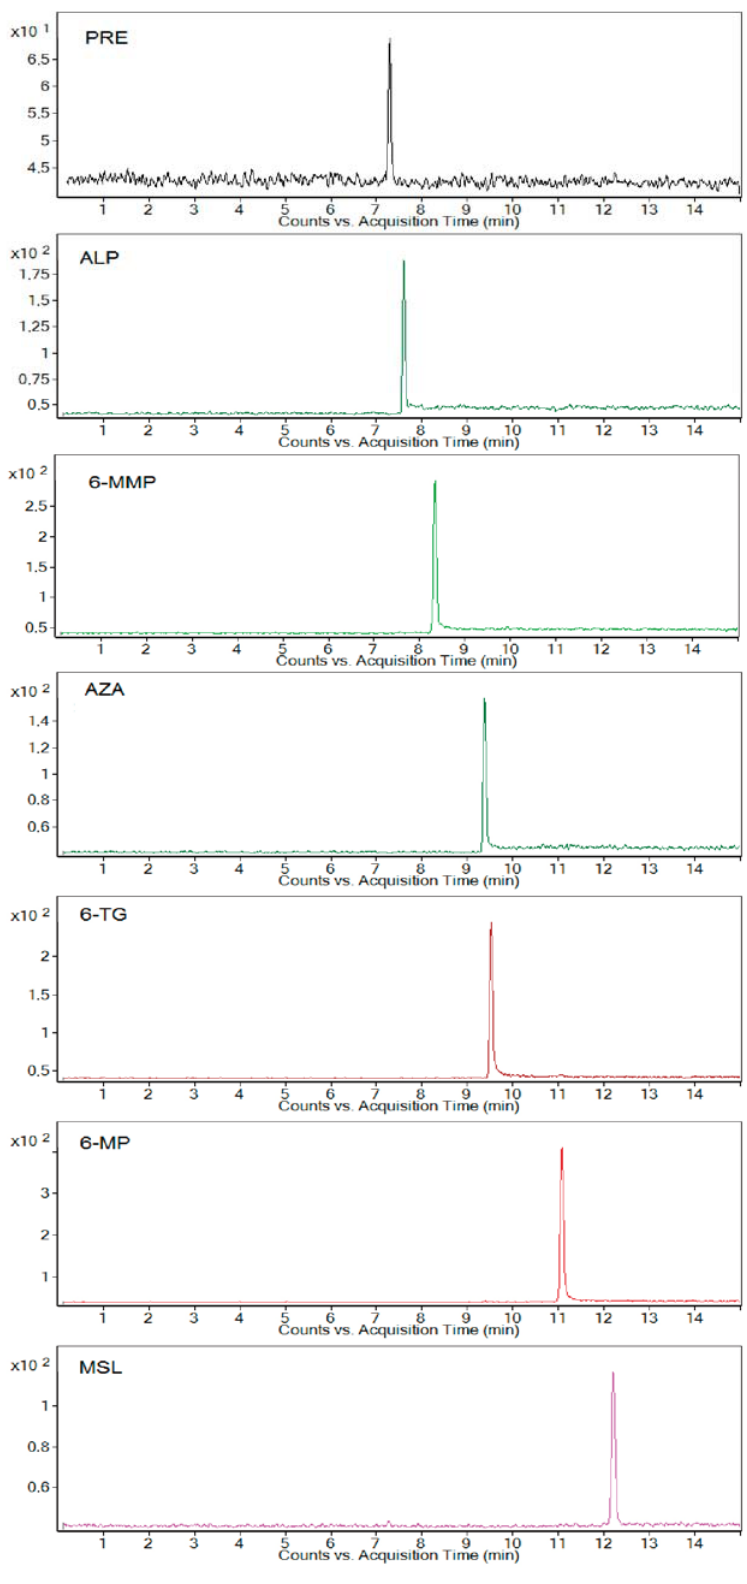
Figure 1. Analysis of model human urine sample. Multiple reaction monitoring mode (MRM) transitions from CE-ESI-MS/MS analysis of 10-fold diluted blank urine sample spiked with the mixed standard solution (concentration level of all analytes was 2.5 µ g · mL − 1 ). For the preparation of the sample and other working conditions, see Section